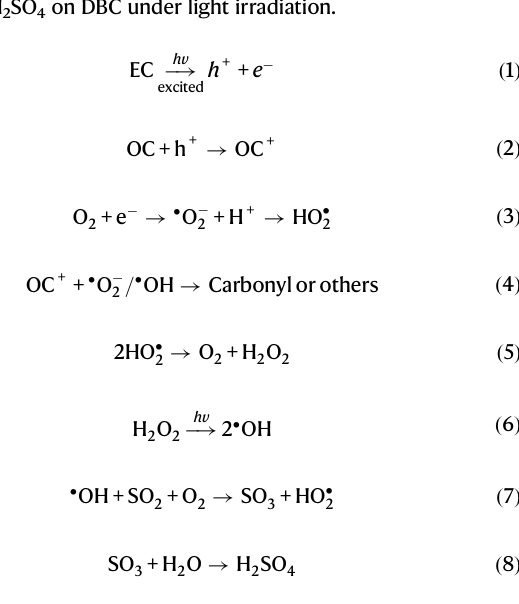
Fig. 4 | Photo-induced OH radical promoting the heterogeneous conversionof SO 2 to H 2 SO 4 . BMPO spin-trapping ESR spectra for the detection of OH radical in DBCsuspensionunderlightirradiation( a ).BMPOspin-trappingESRspectraforthe detection of OH radical in DBC suspension in the dark and in water under light